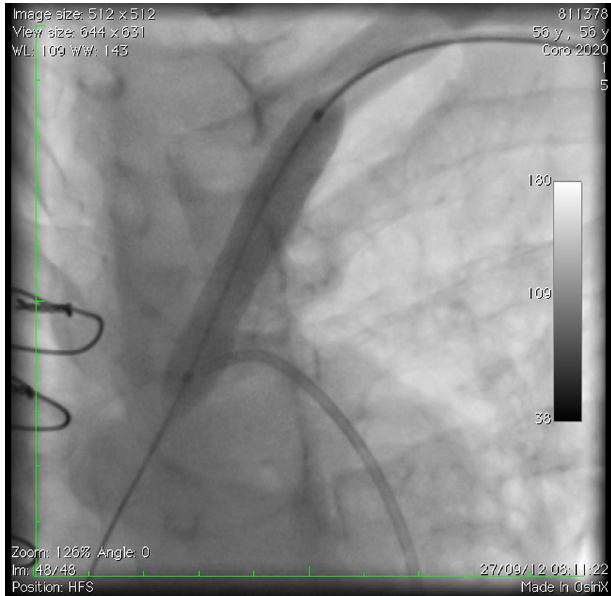
Fig. 3 - Balloon Expandable stent being released by brachial access